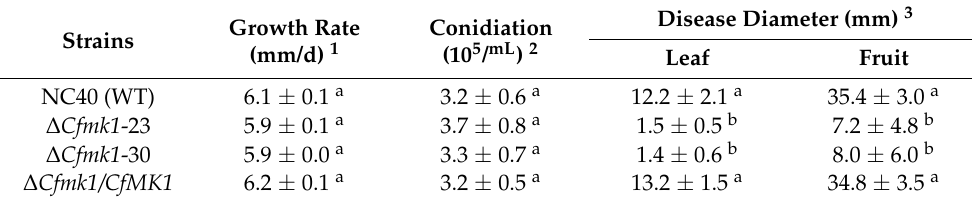
Table 1. Defects of the ∆ Cfmk1 mutant in growth, conidiation, and plant